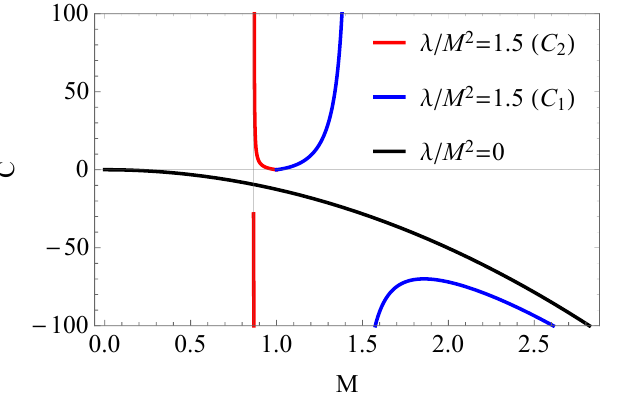
Figure 5. The plot showing the heat capacity of the black hole as a function of the black hole mass for a fixed values of the coupling parameter λ . For C h < 0, the black hole is